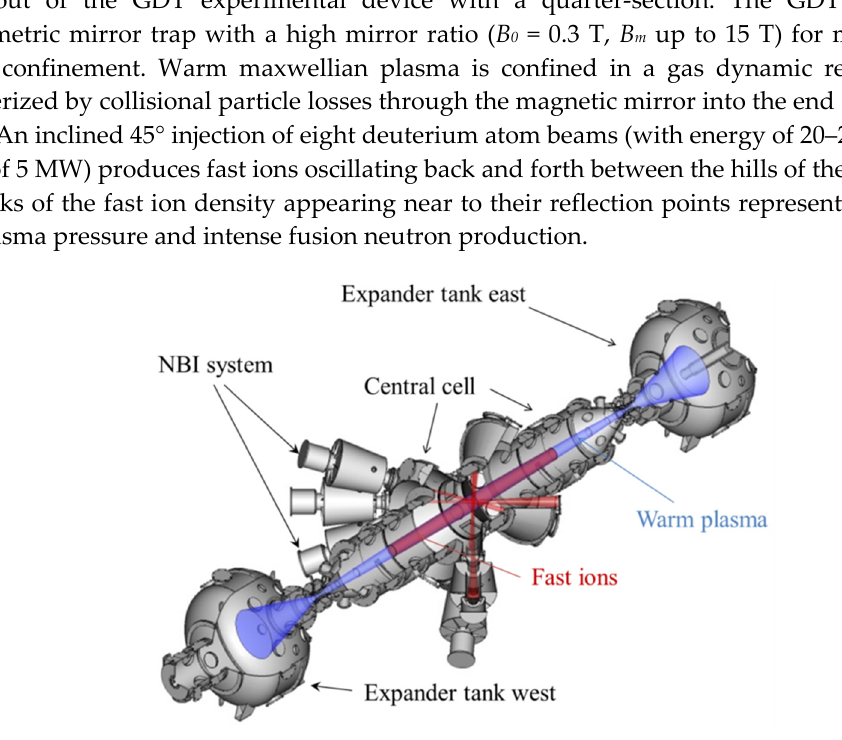
Figure 1. The layout of the GDT